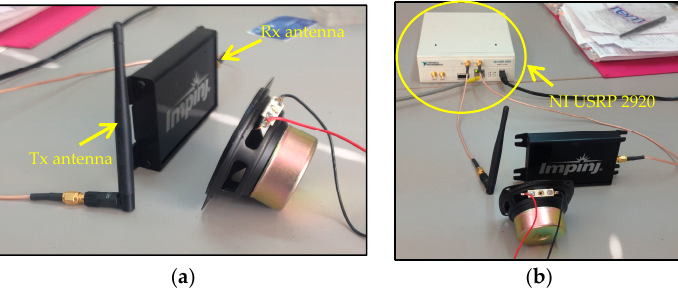
Figure 9. Experimental setup: ( a ) vibrating membrane i n the presence of Tx and Rx antennas; ( b ) full SDRadar Doppler configuration.